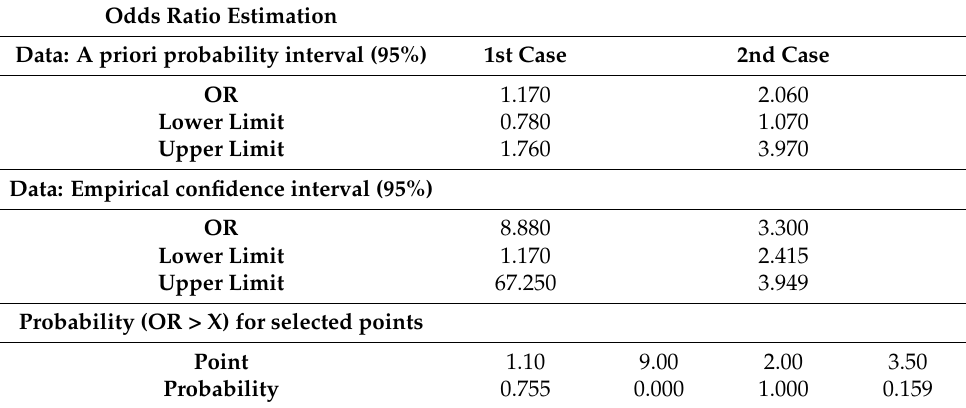
Table 4. Results of the Bayesian analysis of all